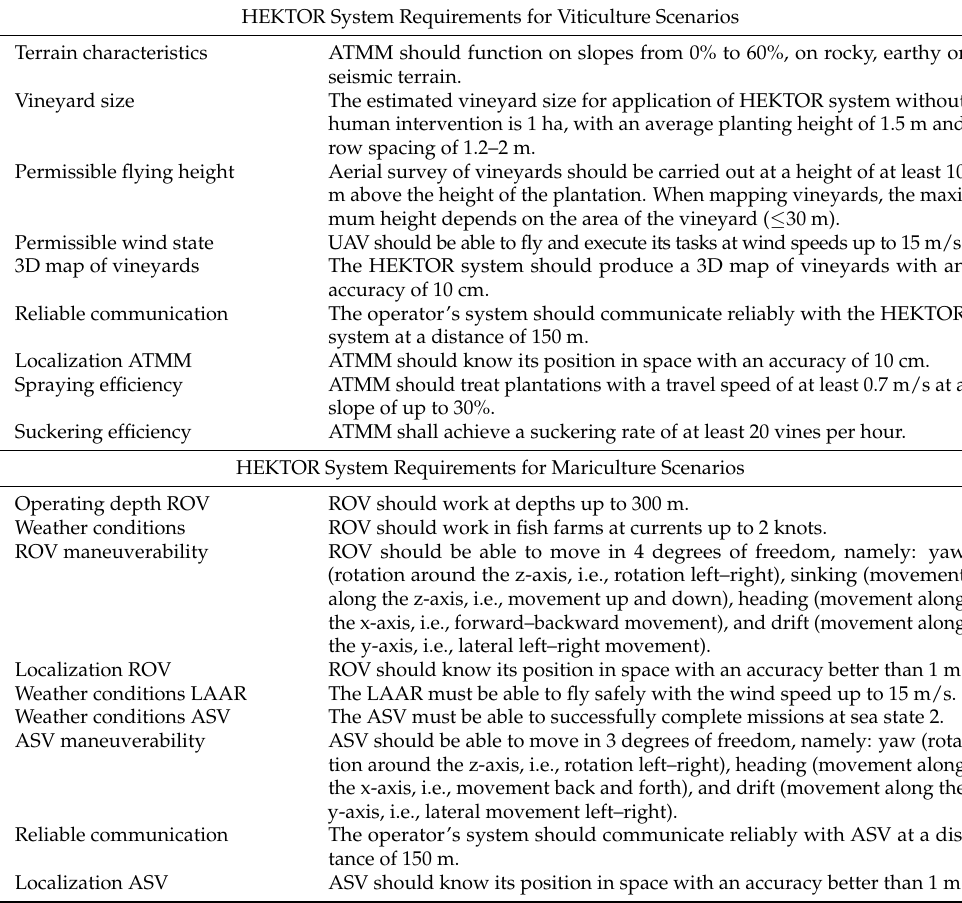
Table 3. The list of selected HEKTOR system requirements. HEKTOR System Requirements for Viticulture Scenarios